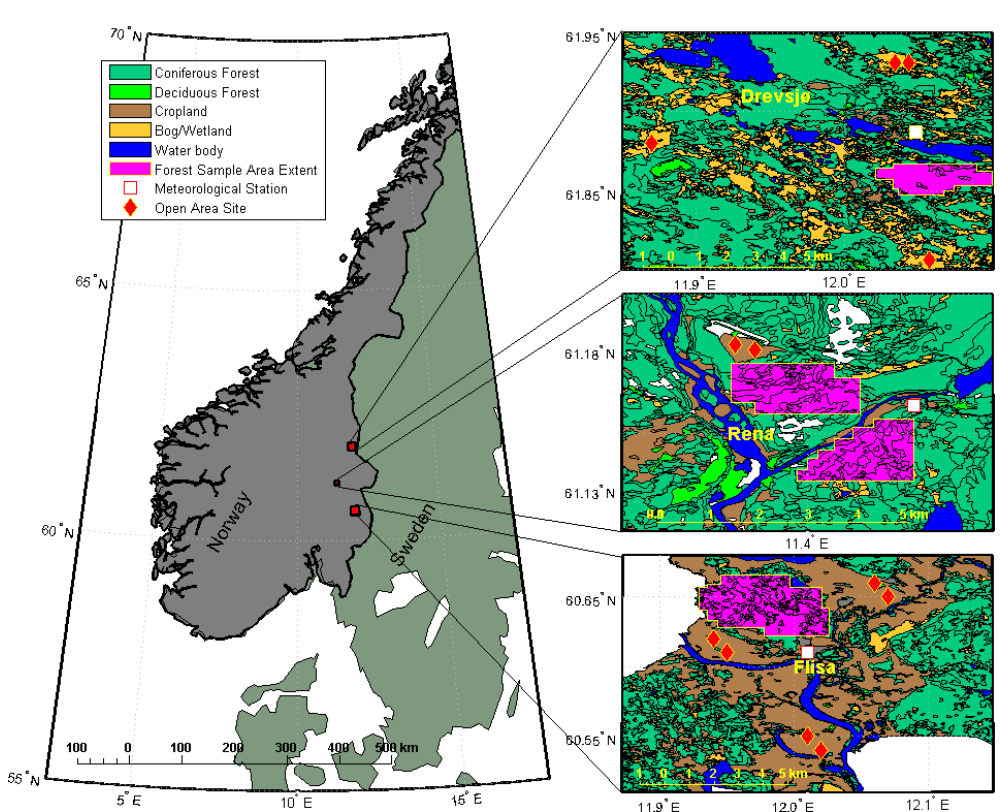
Figure 1. Study regions showing the location of the open (“Cropland” or “Bog/Wetland”) and coniferous forested sites included in the analysis. Meteorological station locations are also